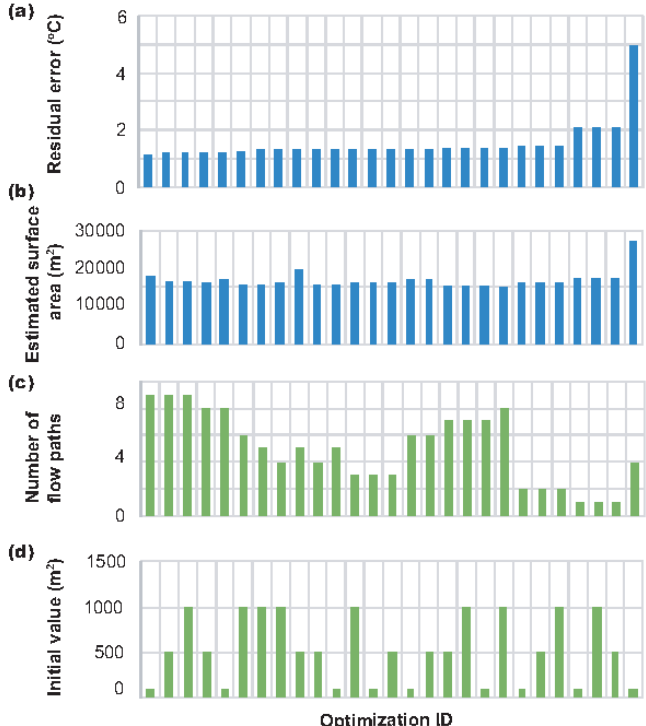
Figure 10. Optimization of surface area between well EE-1 and GT-2B in Fenton Hill HDR reservoir. ( a ) residual errors between field data and calculated curve, ( b ) estimated heat transfer area, ( c ) number of flow paths, and ( d ) initial values for optimization. The optimization ID was arranged in order from the smallest residual errors.